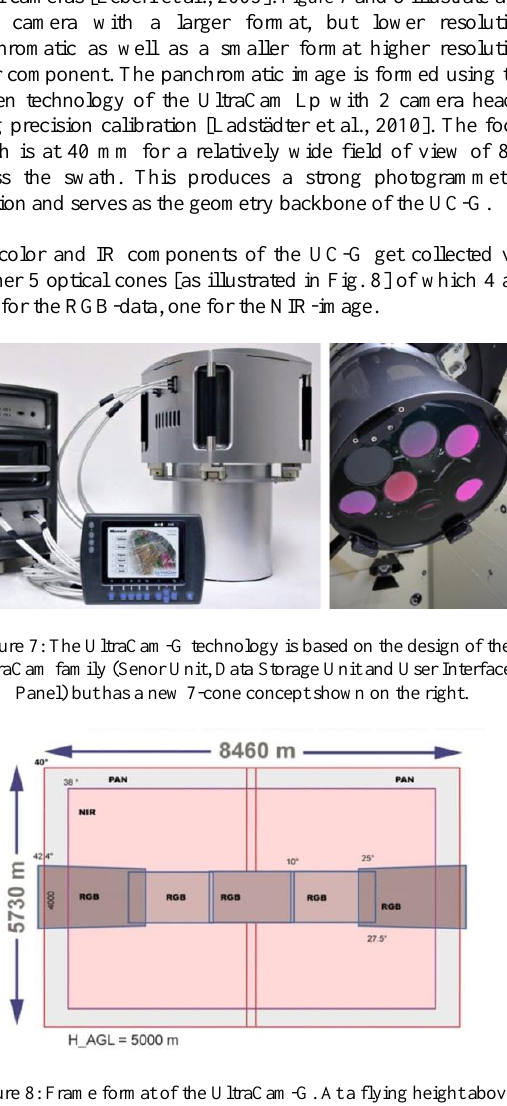
Figure 8: Frame format of the UltraCam-G. At a flying height above ground of 5000 m (16400 ft.) the swath covers > 8 km. Pan and RGB cover the full swath, NIR has a slightly reduced format. The panchromatic image has an aspect ratio ~ 3:2. Two 40 mm optical lenses collect light onto a 90 Mpixel panchromatic